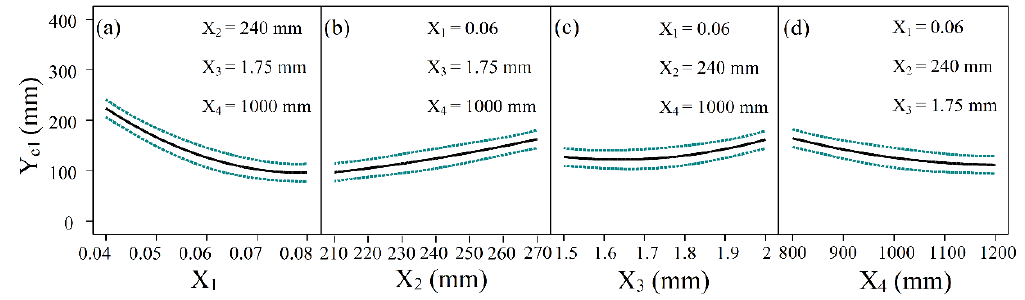
Figure 10. Effect of various factors on the longitudinal radius of positive Gaussian curvature surface: ( a ) Maximum compression ratio; ( b ) Sheet width; ( c ) Sheet thickness; ( d ) Transverse curvature radius.